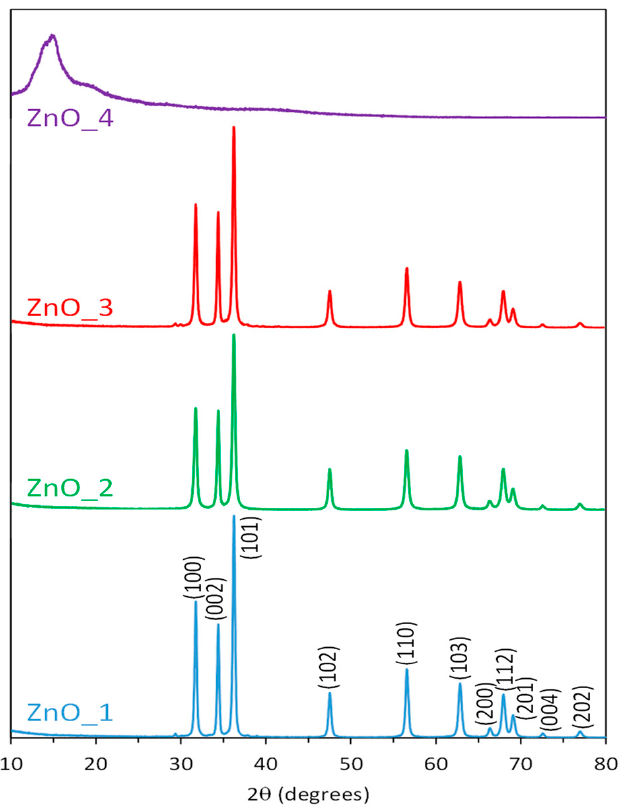
Figure 3. XRD diffractograms for the ZnO samples fabricated in microwave irradiation in the presence of cetyltrimethylammonium bromide (CTABr) and S. officinalis extract.